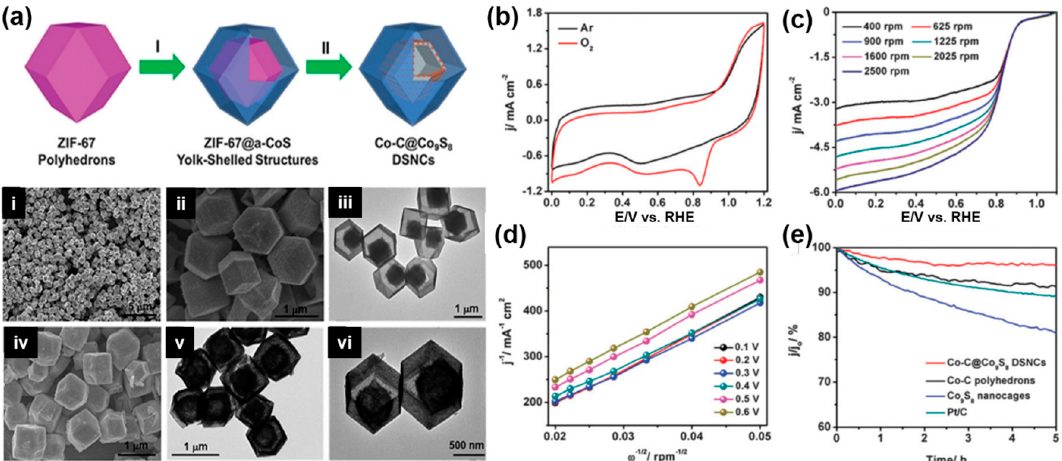
Figure 6. ( a ) The synthesis route of Co–C@Co 9 S 8 DSNCs (double-shelled nanocages); (i–vi) field-emission scanning electron microscopy (FESEM) and TEM micrographs of the catalyst; ( b ) CV curves